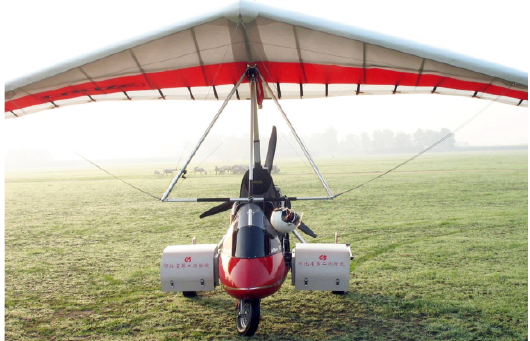
Figure 2. Microlighte-Trike as a platform for aerial surveying for monitoring earthquake disasters in China